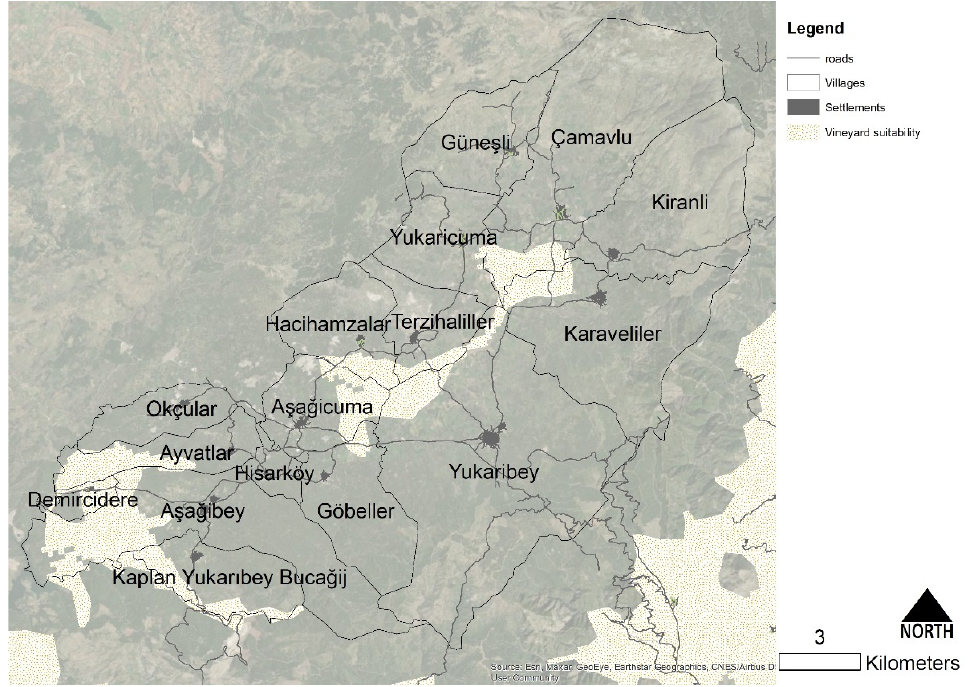
Figure 3. The Kozak Plateau. Source: author’s elaboration.